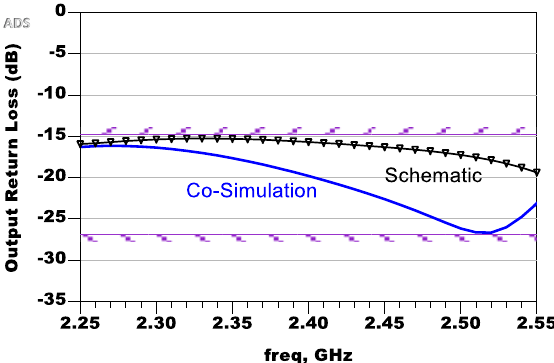
Fig. 14. Output return loss curves (schematic and EM Co- Simulation) versus frequency